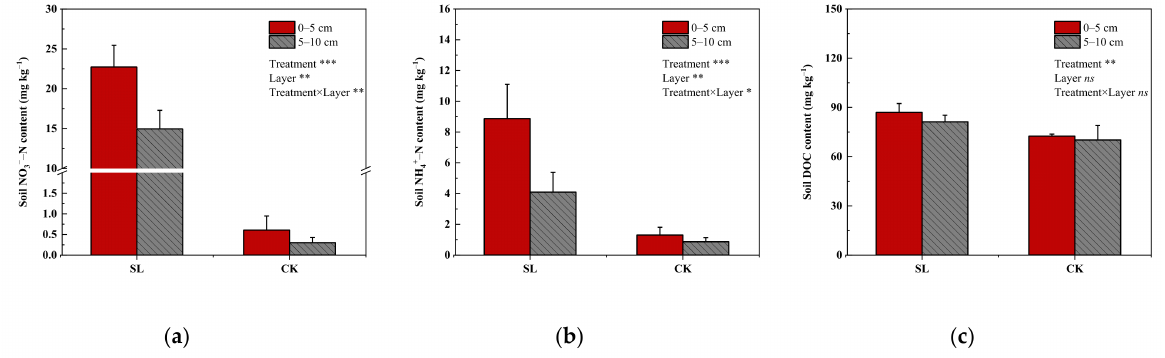
Figure 3. Effects of sewage sludge (SS) application on ( a ) soil NO 3 − –N content, ( b ) NH 4+ –N content, and ( c ) soil DOC content at 0–5 cm and 5–10 cm layers in the Mongolian pine plantation. SL, SS application treatment; CK, control treatment without SS application. The values are the mean ± SD ( n = 3). *** p < 0.001; ** p < 0.01; * p < 0.05; ns , not significant.